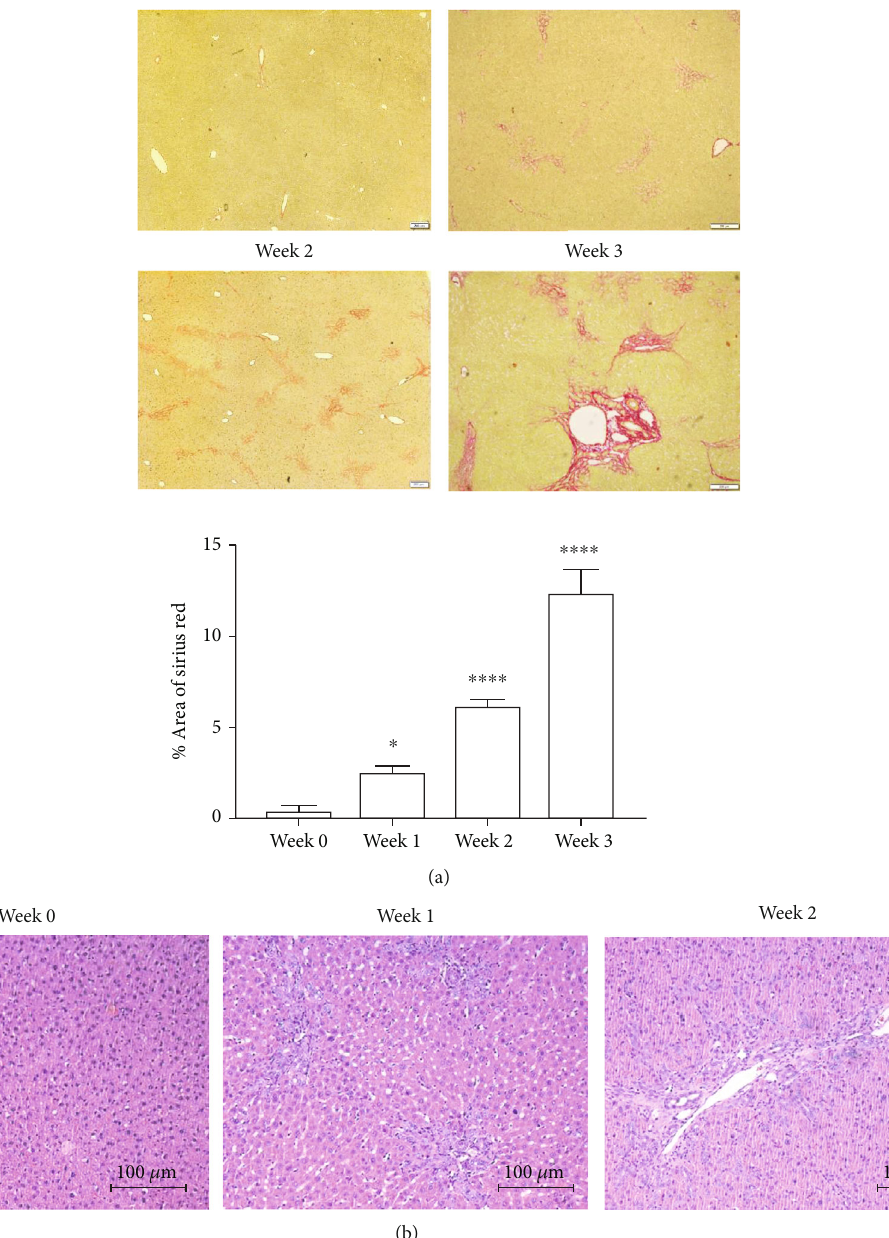
Figure 3: Histological assay of liver fi brosis: (a) Sirius red staining; (b) hematoxylin and eosin staining. ∗ P < 0 : 05 ; ∗∗ P < 0 : 01 ; ∗∗∗ P < 0 : 001